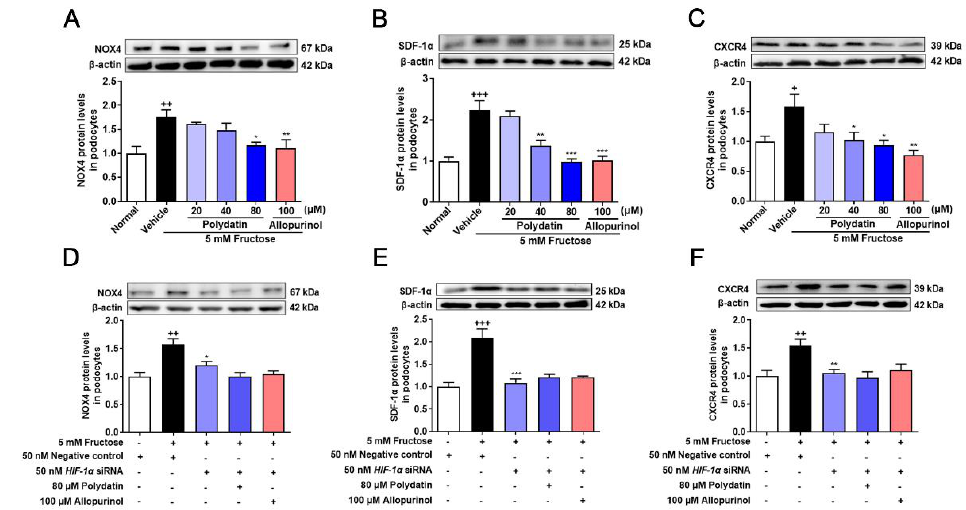
Figure 3. Polydatin suppresses HIF-1 α /NOX4 pathway activation in fructose-cultured podocytes.